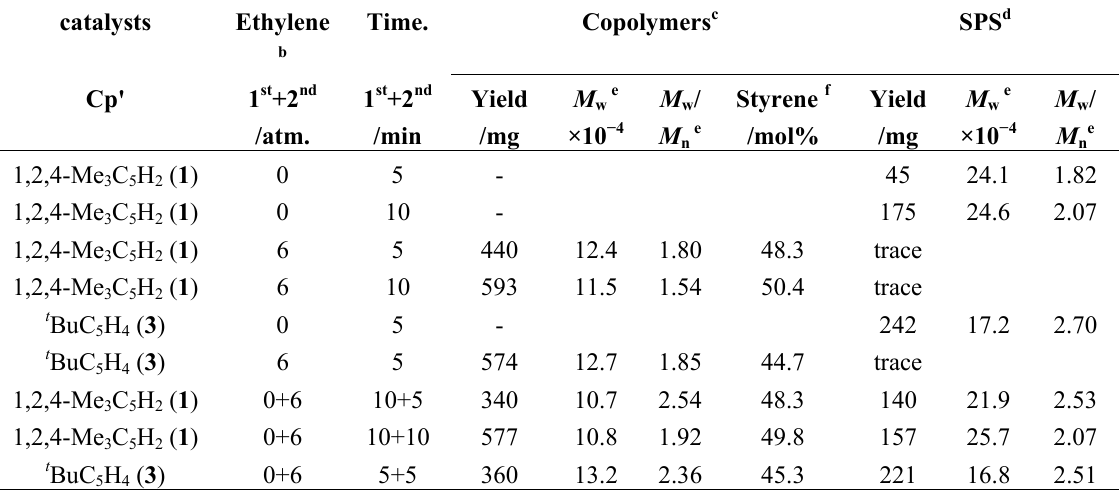
( O -2,6- i Pr C H 2 2 6 3